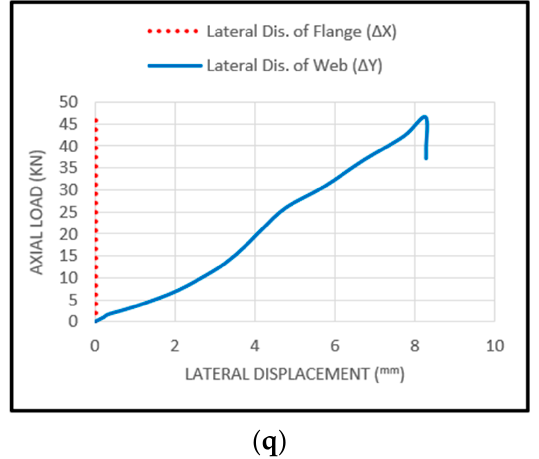
Figure 5. The load–lateral displacement curves for different specimens according to the experimental test. ( a ) C70-63.5-1.5-P-500; ( b ) C70-63.5-1.5-P-1000; ( c ) C90-80-1.5-P-500; ( d ) C90-80-1.5-P-1000;